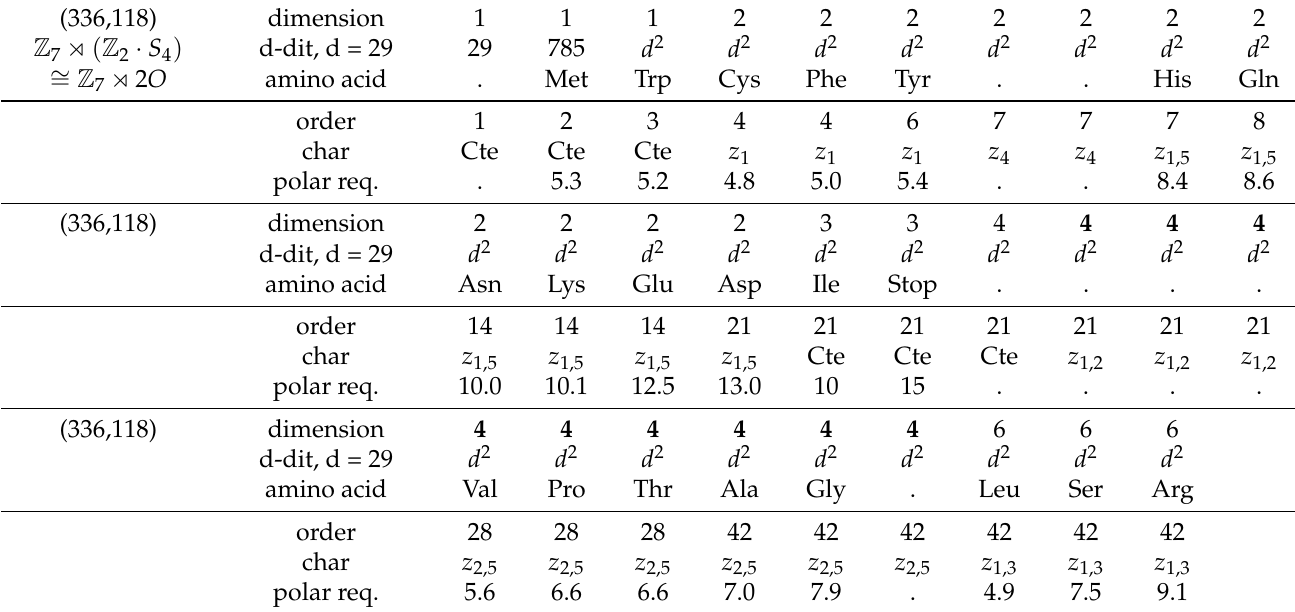
Table 4. For the group G 7 : = ( 336,118 ) ∼ = Z 7 (cid:111) 2 O , the table provides the dimension of the representation, the rank of the Gram matrix obtained under the action of the 29 -dimensional Pauli group, the order of a group element in the class, the angles involved in the character and a good assignment to an amino acid according to its polar requirement value. Bold characters are for faithful representations. All characters are informationally complete except for the trivial character and the one assigned to ‘Met’. The entries involved in the characters are z 1 = 2cos ( 2 π /7 ) , z 2 = 2 z 1 , z 3 = − 6cos ( π /7 ) , √ z 4 = 2 and z 5 = 2cos ( 2 π /21 ) featuring the angles 2 π /8 (in z 4 ), 2 π /7 and 2 π